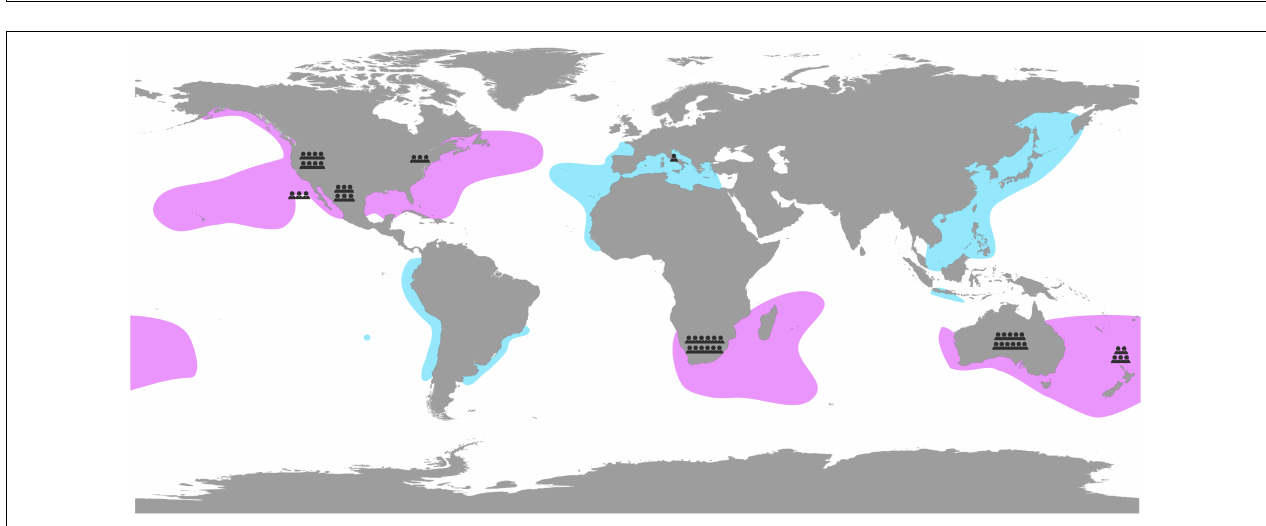
FIGURE 1 | Annual number of white shark publications (1980–2018) based on a Web of Science search (12 June 2018) for items with titles including “white shark(s)” and/or “ Carcharodon carcharias ”. The large numbers of publications in 1985, 1996, and 2012 are due to the publication of books or symposium proceedings about white sharks. ∗ in 2018 indicates that it does not represent a full 12 months.